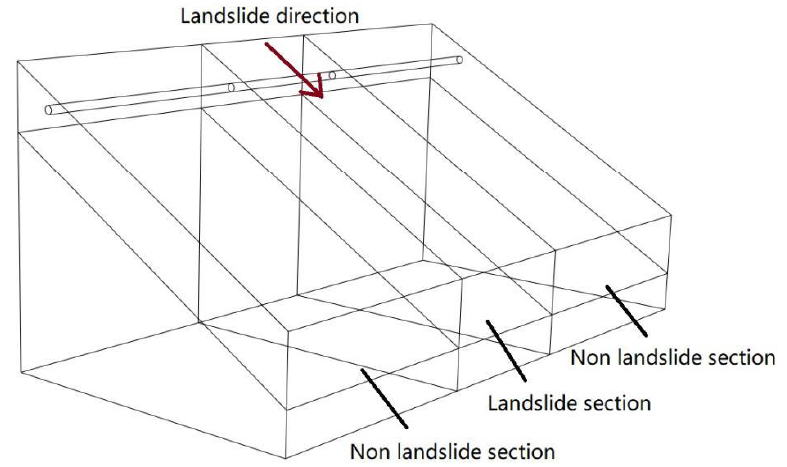
Figure 2. Schematic illustration of soil model.